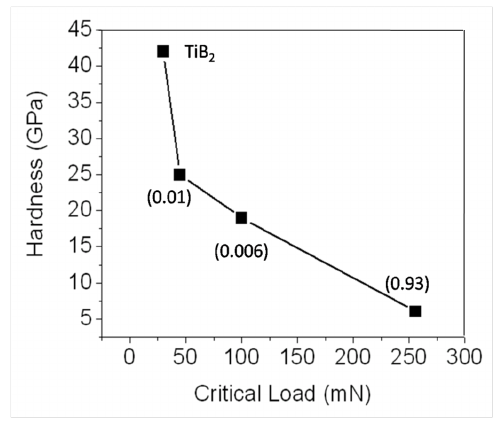
Figure 20: Hardness vs Critical load for the Ti-B-N films, the paren- thesis shows the nitrogen